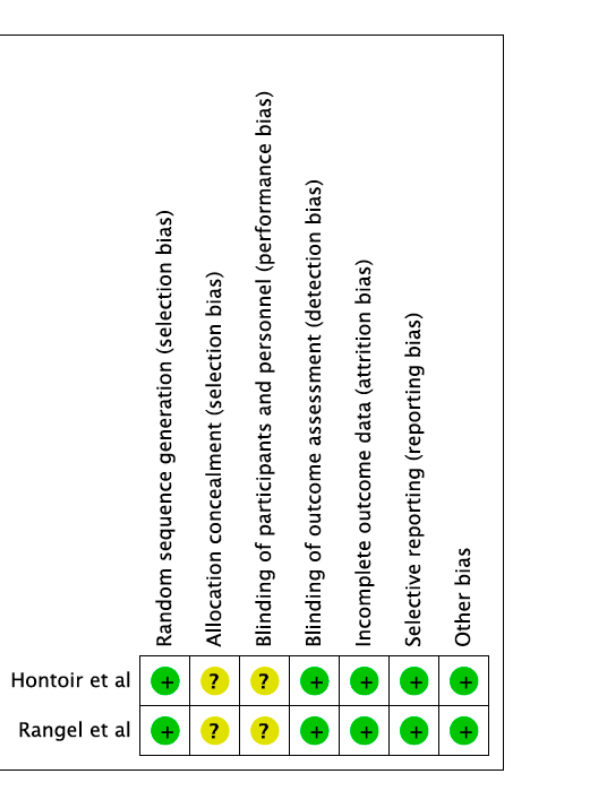
Figure 2. Risk of bias summary. Review authors’ judgements about each risk of bias item for each included study.